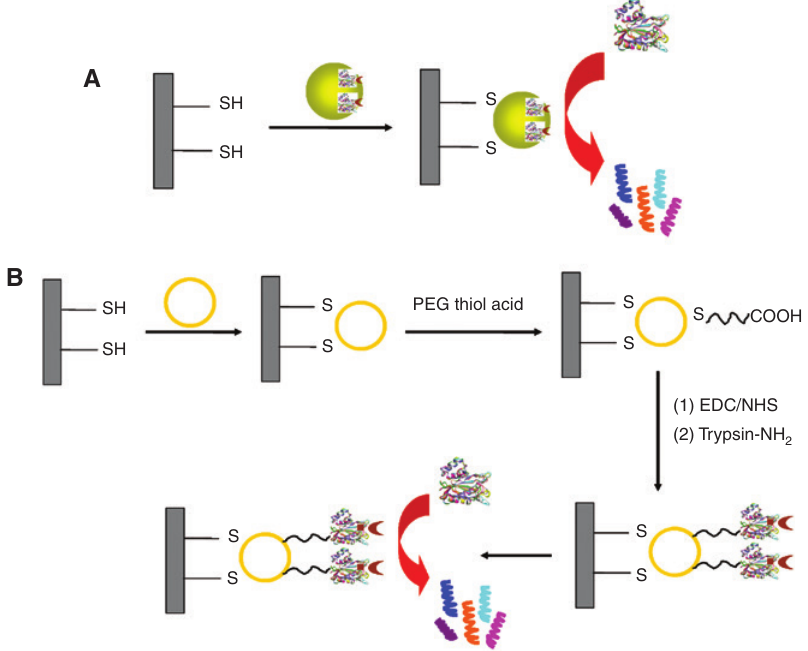
Figure 4: (A) Preparation of GNP microreactor with adsorbed trypsin and (B) preparation of GNP microreactor with trypsin immobilized via PEG